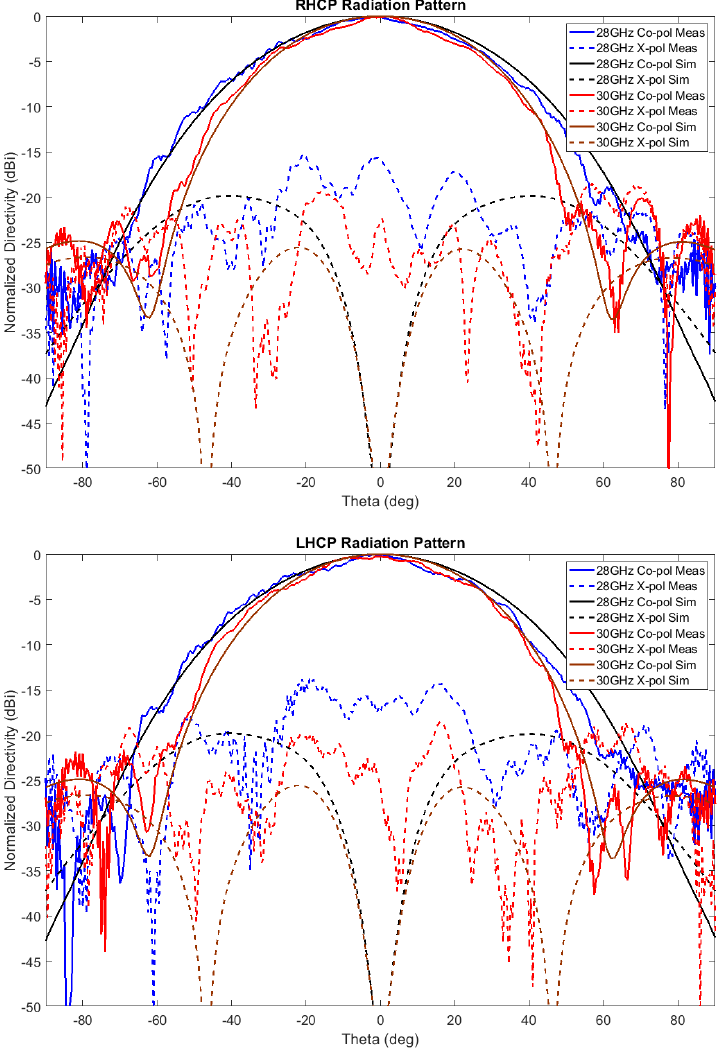
Figure 10. 2 × 2 array normalized radiation patterns at ϕ = 0 ◦ for RHCP ( above ) and LHCP ( below ).